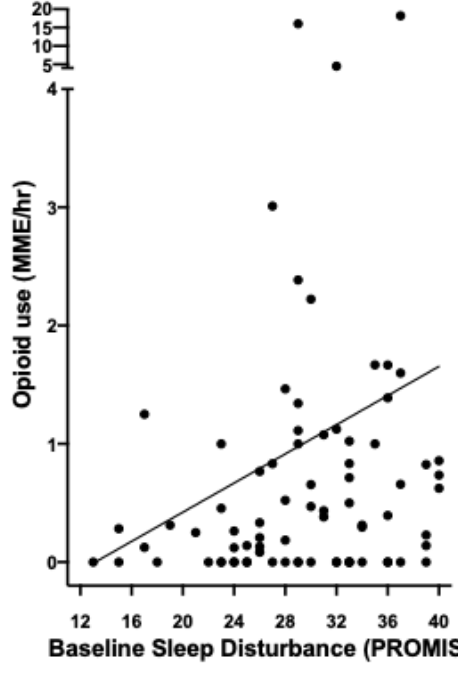
Figure 4. Variation in opioid use among participants with baseline sleep disturbance. Baseline sleep disturbance (measured by the Patient-Reported Outcomes Measurement Information System [PROMIS] short form) was associated with a higher amount of opioid consumption (milligram morphine equivalent [MME]) per hour while in the emergency department (Spearman ρ =0.24, P